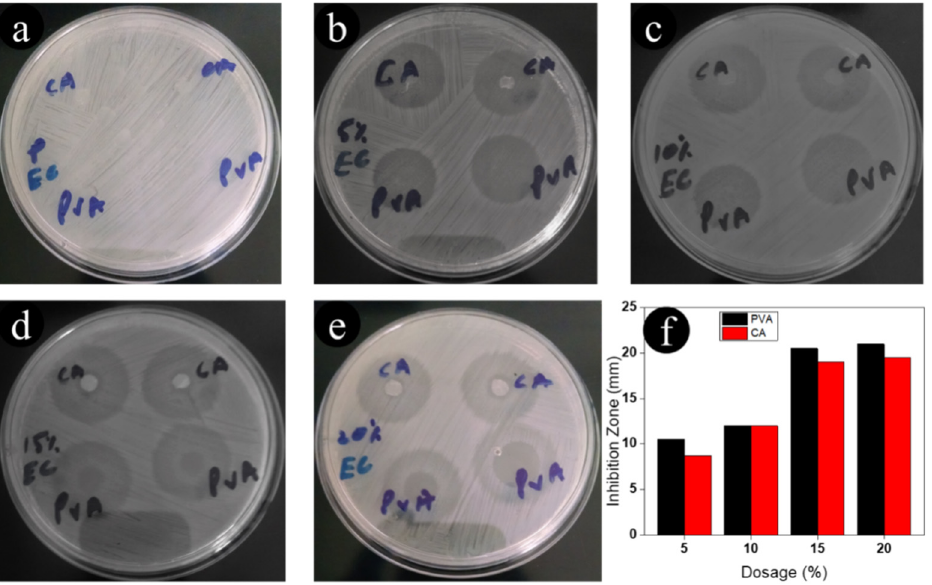
Figure 4. Antimicrobial assessment of CA and PVA nanofibers incorporated with different amounts of ceftriaxone, ( a ) 0, ( b ) 5%, ( c ) 10%, ( d ) 15%, and ( e ) 20% against S. aureus ; ( f ) is a bar graph of the inhibition zones.